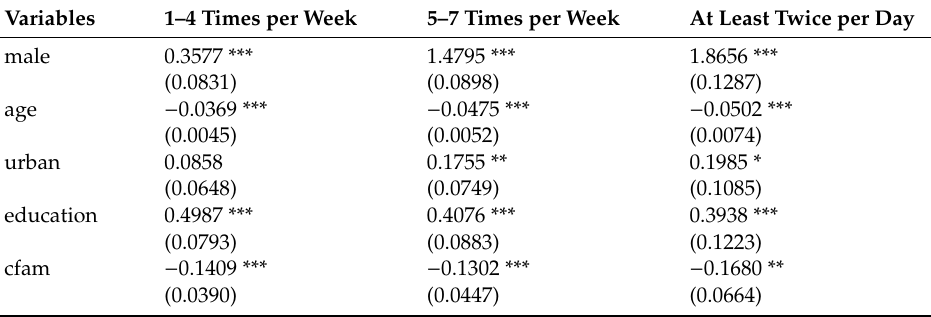
Table 4. Estimation results for the treatment model by Multinomial